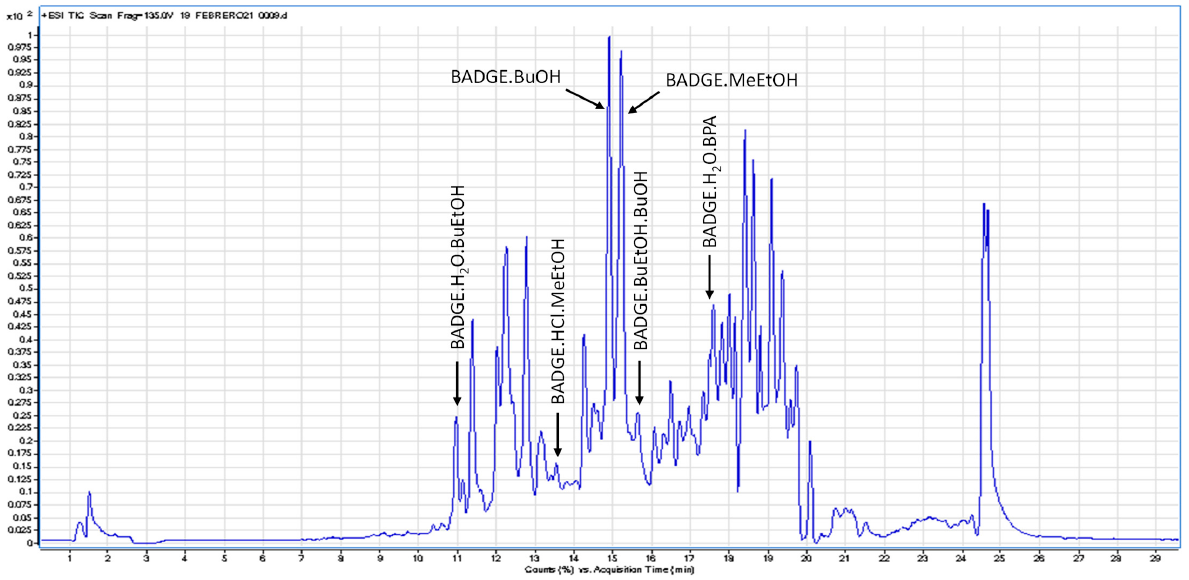
Figure 3. LC-MS Scan chromatogram of the octopus’s sample (S40) with the identi fi cation of some reaction products of